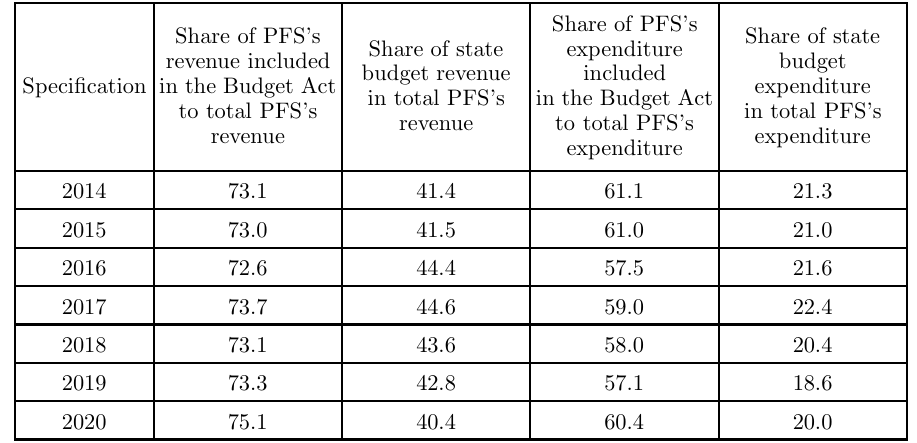
Public revenue and expenditure included in the Budget Act against the background of total public revenue and